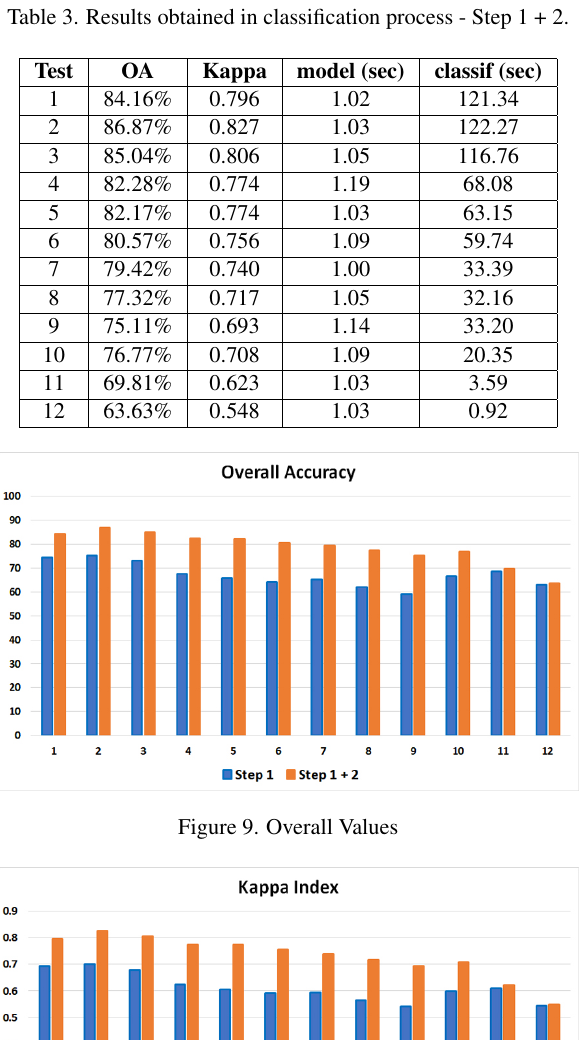
Table 3. Results obtained in classification process - Step 1 + 2.